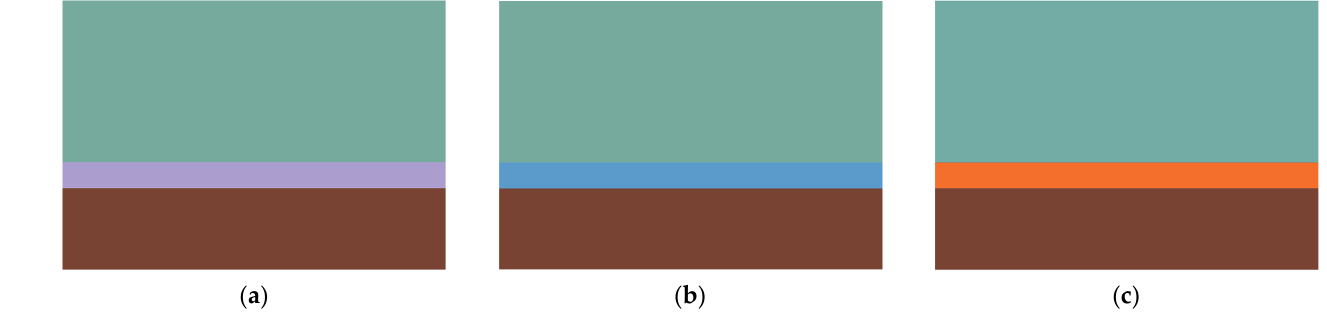
Figure 13. Charts 30-1 ( a ), 30-2 ( b ), and 30-3 ( c ) from Section IV.